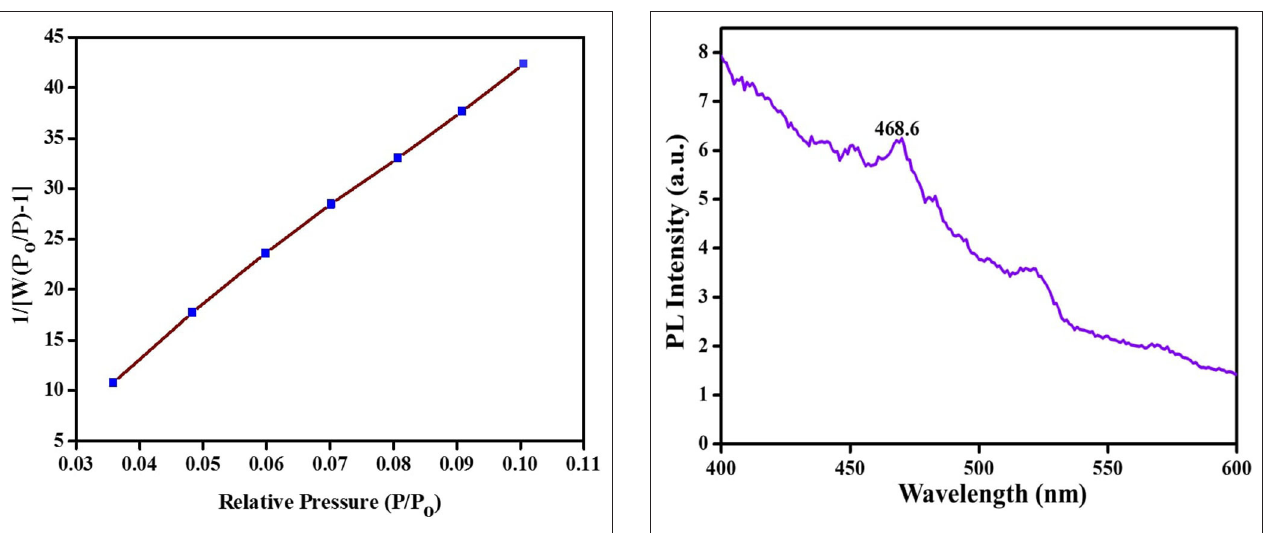
FIGURE 10 | BET plot of the synthesized green TiO 2 NPs.